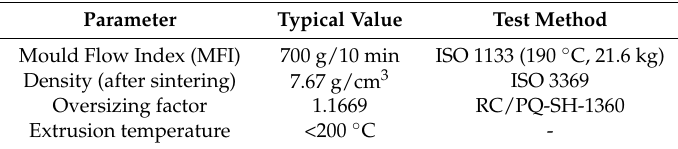
Table 2. Technical data of Catamold ® 17-4PH F.